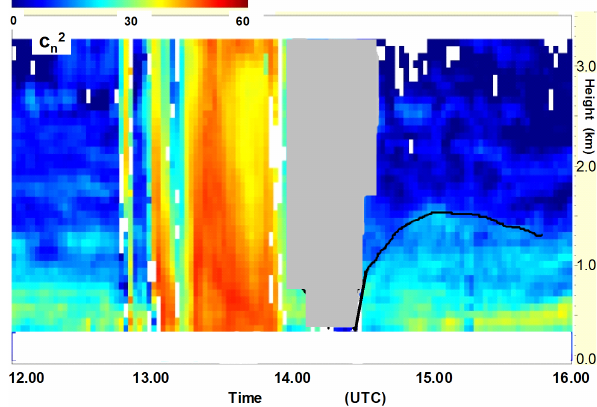
Fig. 8c. Range corrected signal to noise ratio measured by the wind profiler at Linkenholt 24 June 2005, 12:00–16:00UTC. The esti- mated top of the boundary layer is marked with a black